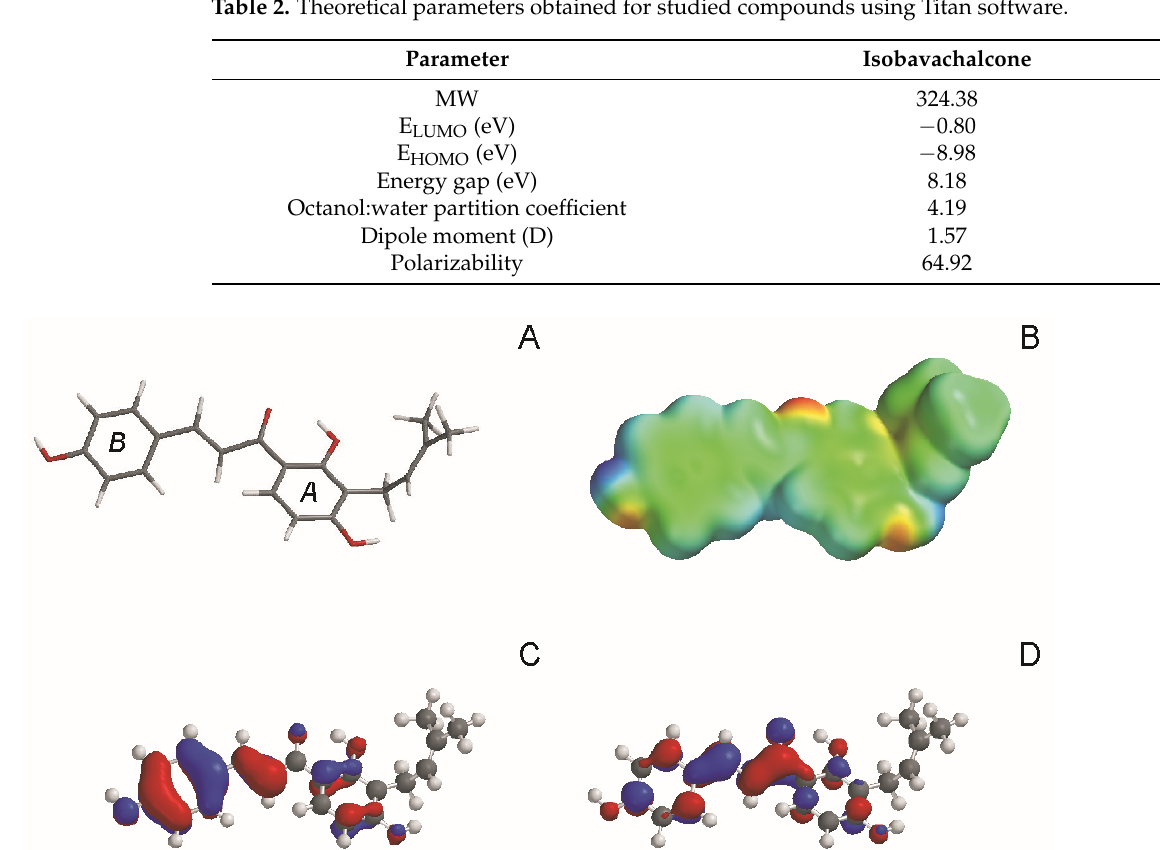
Table 2. Theoretical parameters obtained for studied compounds using Titan software.